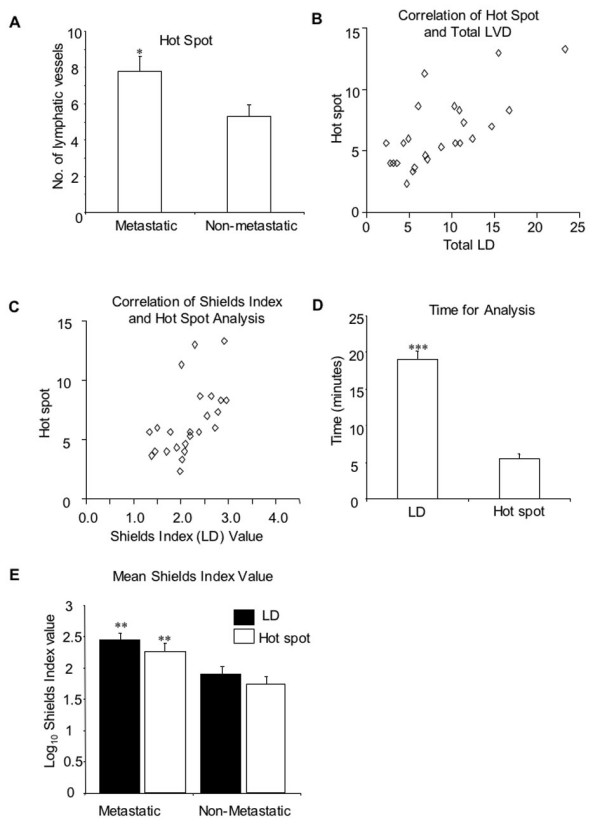
Comparison of total lymphatic vessel density and hot spot analysis. Hot spot analysis and total LD were calculated. Hot spot analysis assessed lymphatic number by counting the number of immunohistochemically stained lymphatic vessels, in three regions with the highest LD, as assessed by eye, in a 100 μm border around the tumour. A) Hot spots (p < 0.05, unpaired t test) in 12 patients that later developed metastases (metastatic) and 12 patients which after 9 years follow-up did not. Error bars represent standard error of the mean. B) Total epi-tumoural LD and hot spot analysis were significantly correlated (p < 0.0001, Pearson, r2 = 0.50). C) The Shields Index and hot spot analysis significantly correlated together (p < 0.01, Pearson, r2 = 0.30) D) Time taken to calculate a Shields Index value compared to the time taken to calculate hot spot analysis in the same subset of patients (p < 0.0001, unpaired t test). E) Shields Index calculated by LD or hotspot are not different from each other.